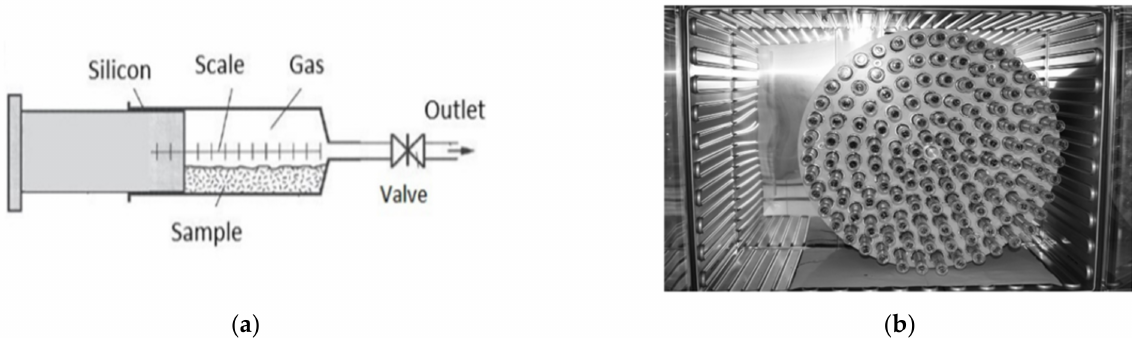
Figure 1. Experimental setup of Hohenheim Biogas Yield Test (HBT) with syringe ( a ) and rotational drum ( b ) placed in the incubator